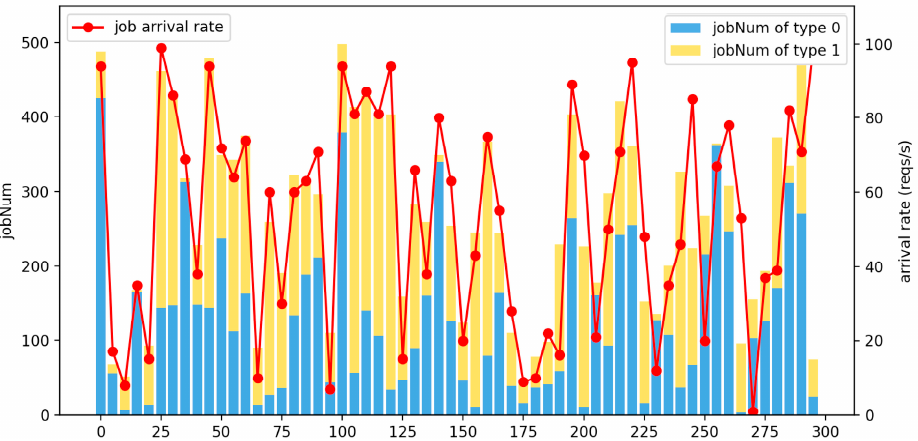
Figure 5. Job arrival rate in random workload mode.